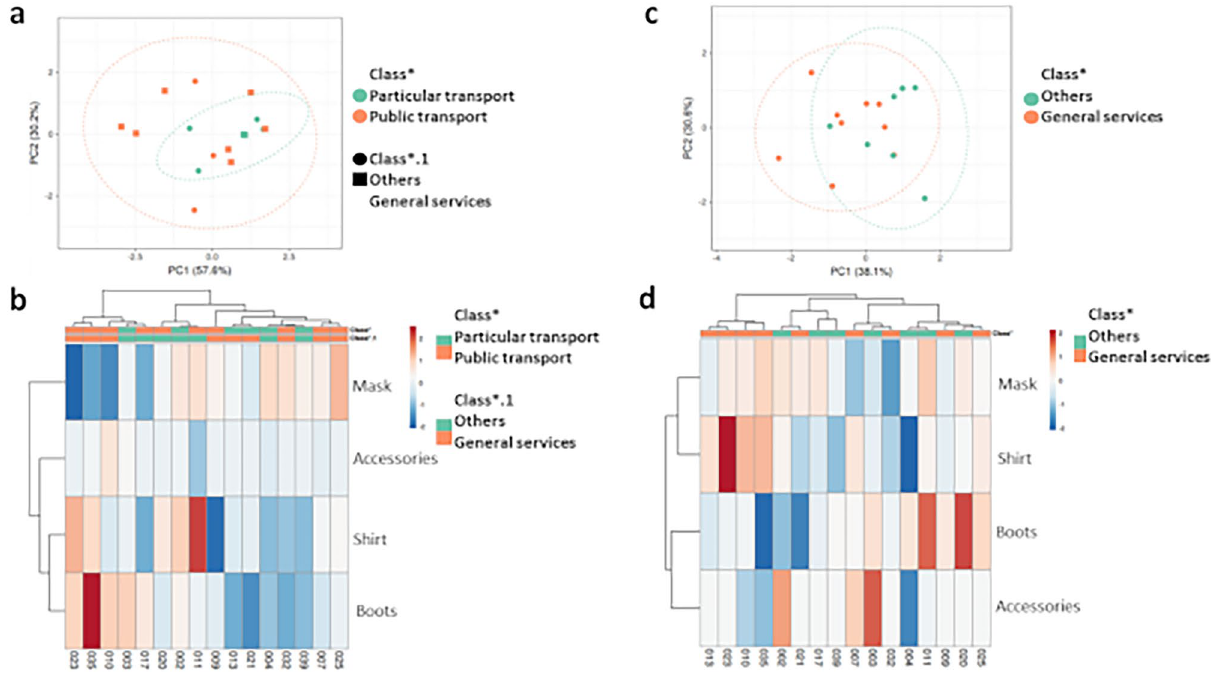
Figure 6. Confluent Log 10 reduction analysis, after passing through the disinfection chamber. ( a , c ) PCA Graph for analysis of data referring to the 1st pass performed by the participants. No scale is applied to the lines and SVD with imputation is used to calculate the principal components. The X and Y axes show the main component 1 (PC1) and the main component 2 (PC2) which explain 57.6% and 30.2% of the total variation, respectively. Prediction ellipses were set to a probability of 0.95 and illustrate grouping by mode of transport and function classification, with indicated labels. ( b ) Heat map for data analysis referring to the 1st pass performed by the participants. The lines are centered and no scaling is applied to the lines. Imputation is used to estimate the missing value. Both rows and columns are grouped using the correlation distance and the average link. ( c ) PCA graph for data analysis referring to the 2nd pass performed by the participants. No scale is applied to the lines and SVD with imputation is used to calculate the principal components. The X and Y axes show the main component 1 (PC1) and the main component 2 (PC2) which explain 38.1% and 30.6% of the total variation, respectively. Analysis settings were the same as indicated in ( a ). ( d ) Heat map for data analysis referring to the 2nd pass performed by the participants. Analysis settings were the same as indicated in ( b